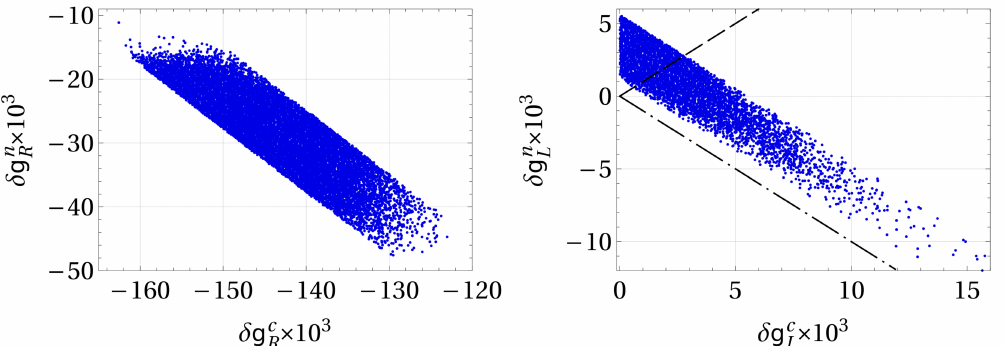
Figure 12 . Scatter plot of 3HDM points that obey the S - and T -oblique parameters constraints, fit solution 2 average at the 1 σ level, and have m 100 GeV. Left panel: the neutral-scalar contribution 3 > to δg the charged-scalar contribution to the same quantity. Right panel: the same for δg R versus instead of δg . In the right panel, the dashed line marks the condition δg n R dotted line corresponds to δg n = − δg c . L L